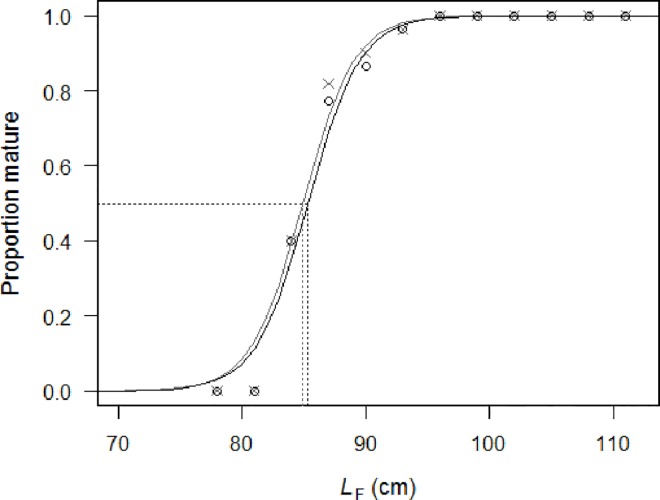
Proportion of mature female albacore in the western Indian Ocean for two different criteria based on 3-cm fork length (LF) interval fitting.The proportion of females mature when their ovaries contained vitellogenic 3 oocytes onwards (first criterion) are represented by circles and the logistic regression curve fitted to the data is indicated by the black solid line. The proportion of females mature when their ovaries contained cortical alveoli oocytes onwards (second criterion) are represented by grey crosses and the logistic regression curve fitted to the data is indicated by the grey solid line. The horizontal dotted line represents the proportion at which 50% of the population of female albacore tuna is mature and the vertical dotted line shows the corresponding LF for each criterion (black and grey for the first and second criteria, respectively).